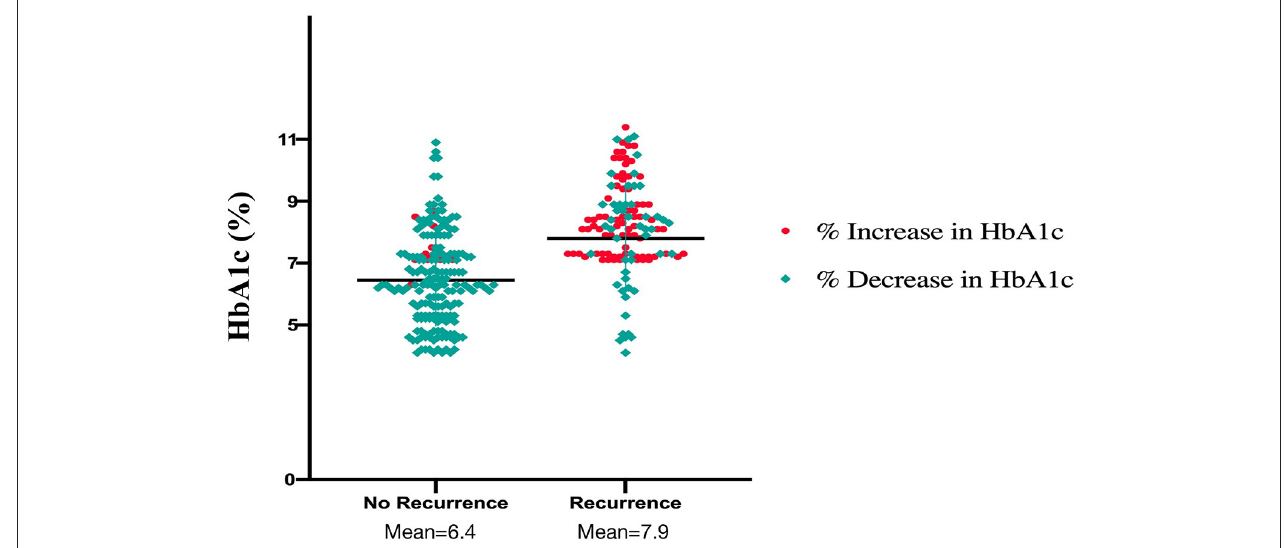
FIGURE 1 | Plasma levels of glycated hemoglobin and the trend of glycated hemoglobin in recurrence and non-recurrence groups.